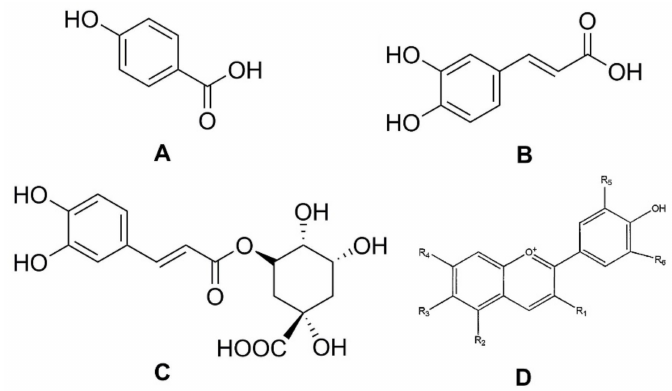
Figure 2. Structures of phenolic acids: ( A ) p -hydroxybenzoic acid; ( B ) ca ff eic acid; ( C ) chlorogenic acid; and ( D ) the basic chemical structure of